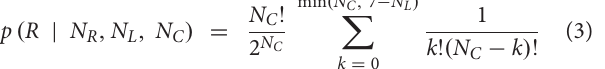
Frontiers in Human Neuroscience |